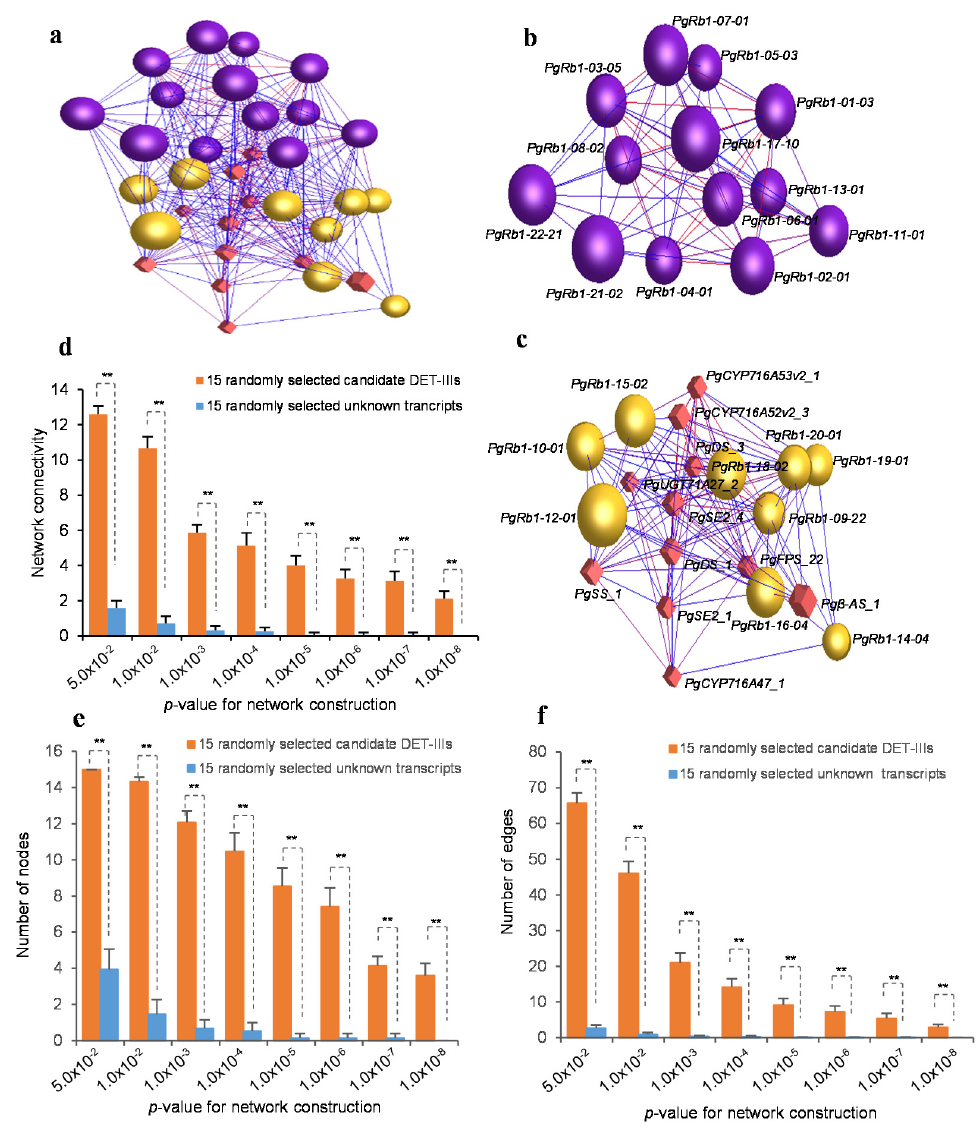
Figure 3. Co-expression network of 22 Rb1 candidate gene transcript DET-IIIs and 11 published Rb1 biosynthesis gene transcripts. ( a ) The co-expression network of the 33 gene transcripts constructed at a cutoff of p ≤ 0.05. The balls (nodes) represent Rb1 candidate gene transcript DET-IIIs, the diamonds (nodes) represent published Rb1 biosynthesis gene transcripts, and the lines (edges) between transcripts represent co-expressions or functional interactions. The network consists of all 22 Rb1 candidate gene transcript DET-IIIs and all 11 published Rb1 biosynthesis gene transcripts